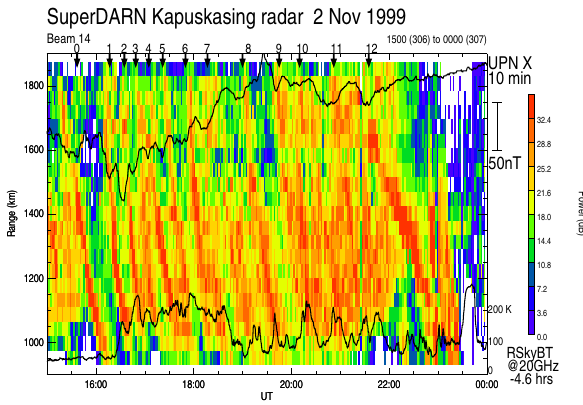
Fig. 2. The Kapuskasing radar ground scatter power modulated by passing TIDs. The UPN ground magnetic field X component is shifted by 10 min. The arrows mark the TIDs that are associated with UPN-X fluctuations. The radiometric sky brightness temperature observed from Ottawa (magnetic latitude 56º) is shifted by 4.6 hours.